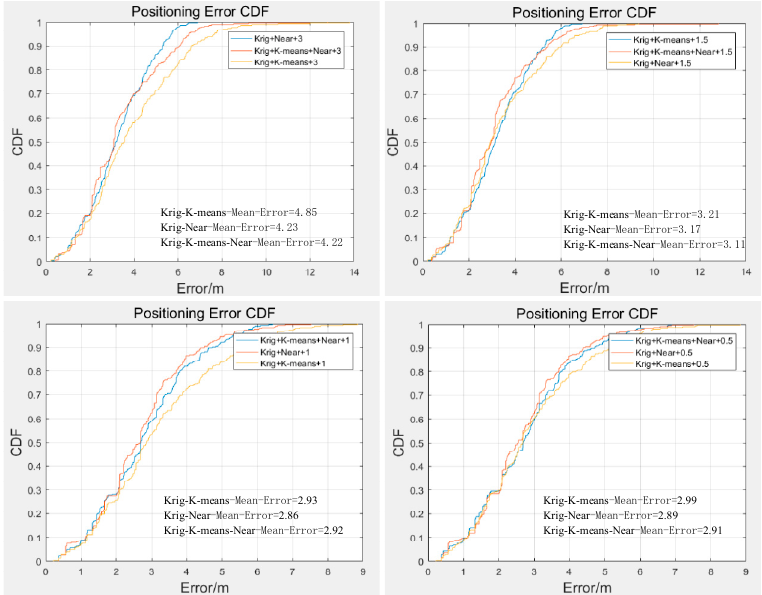
Figure 14. CDF curves of different interpolation methods (i.e., Krig + K-means, Krig + Near, Krig + K-means + Near) under different interpolation densities (i.e., 0.5, 1, 1.5, 3 m).